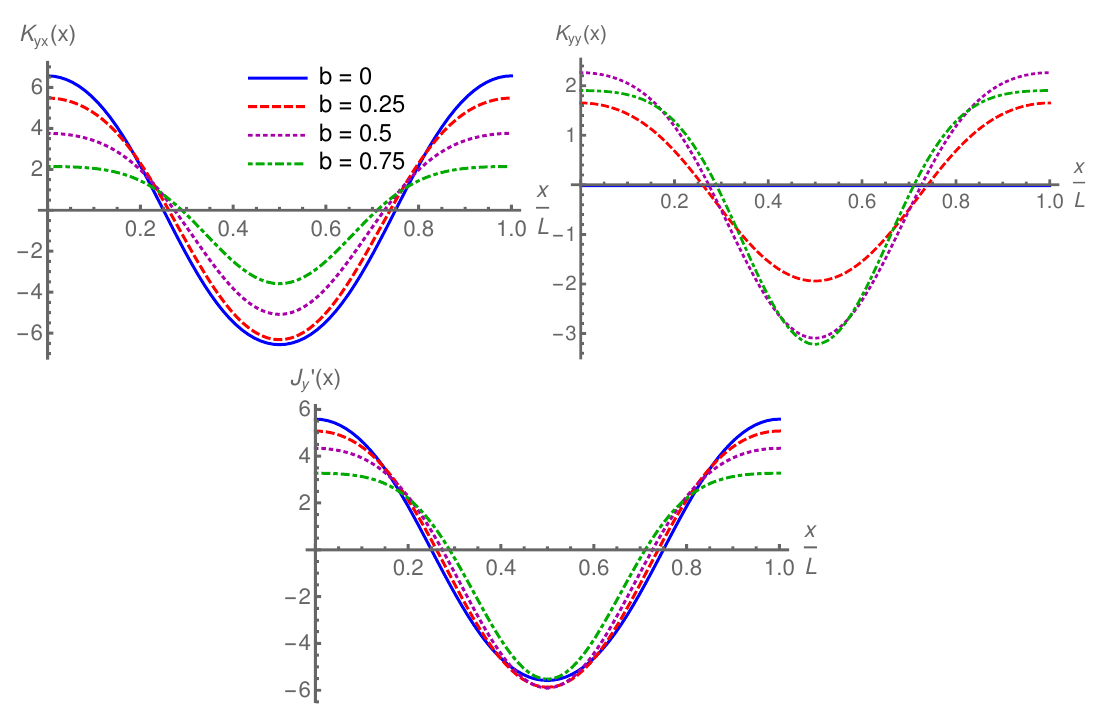
Figure 12 . (Top row) The x -dependence of the weights of the delta functions: (Left) The weight K yx ( x ) in the optical conductivity σ yx ( ω ) ; (Right) The weight K yy ( x ) in the optical conductivity σ yy ( ω ) . (Bottom) The derivative of the background current J 0 ( x ) . The blue, red dashed, magenta y dotted, and green dot-dashed curves are for b = 0 , 0 . 25 , 0 . 5 , and 0 . 75 ,